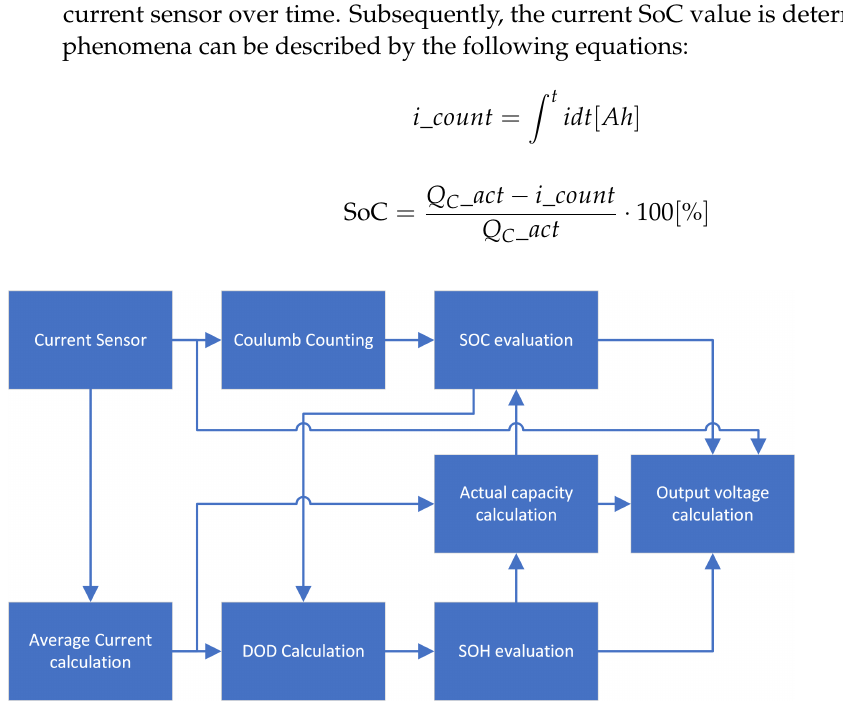
Figure 17. Concept of the proposed model. Internal connections of this block from MATLAB/Simulink are shown in Figure 18.